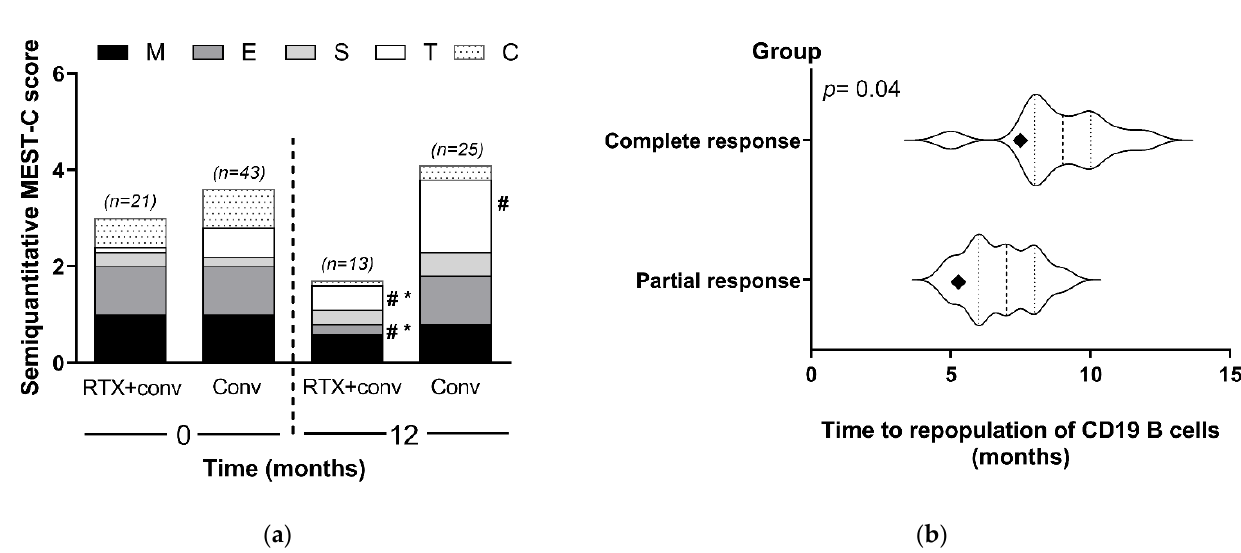
Figure 4. Post-treatment histopathology and immune cells: ( a ) histologic information on renal allograft biopsy at baseline and at 12 months is demonstrated following the MEST-C criteria in the updated Oxford classification of IgA nephropathy (M = mesangial hypercellularity, M0–M1; E = endocapillary hypercellularity, E0–E1; S = segmental glomerulosclerosis, S0–S1; T = tubular atrophy/interstitial fibrosis, T0–T2; and C = cellular or fibro-cellular crescents, C0–C2). ( b ) The duration of CD19 B-cell repopulation after rituximab administration compared between the patients with a complete response (CR) ( n = 8) and those with a partial response (PR) ( n = 10) (participants did not perform testing; n = 3). (Violin plots show the differences in the average (diamond), median (middle line) and time of repopulation). Conv, conventional standard treatment group; RTX, rituximab. # p < 0.05 versus baseline; and * p < 0.05 versus conventional.